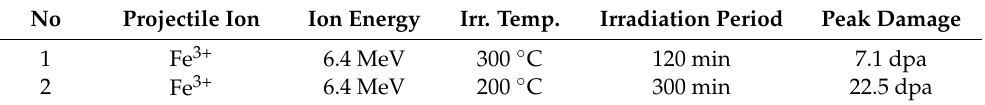
Table 1. Fe ion-irradiation